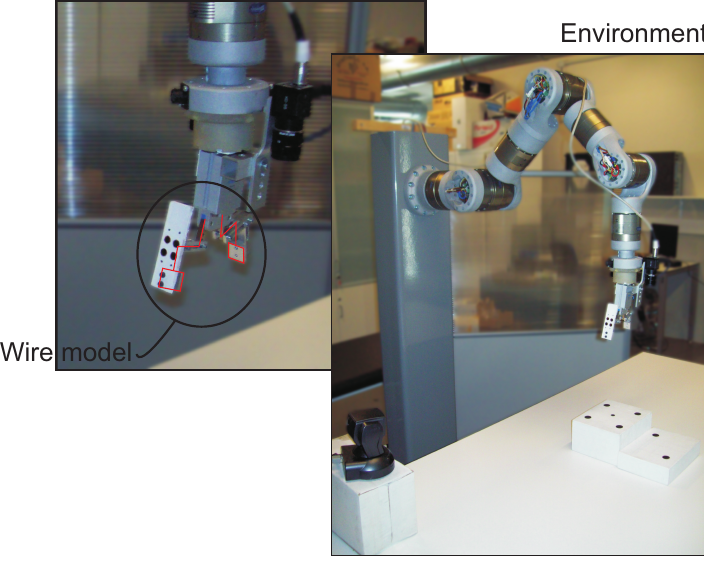
Figure 1. Wire model of the robot gripper with a software and environment